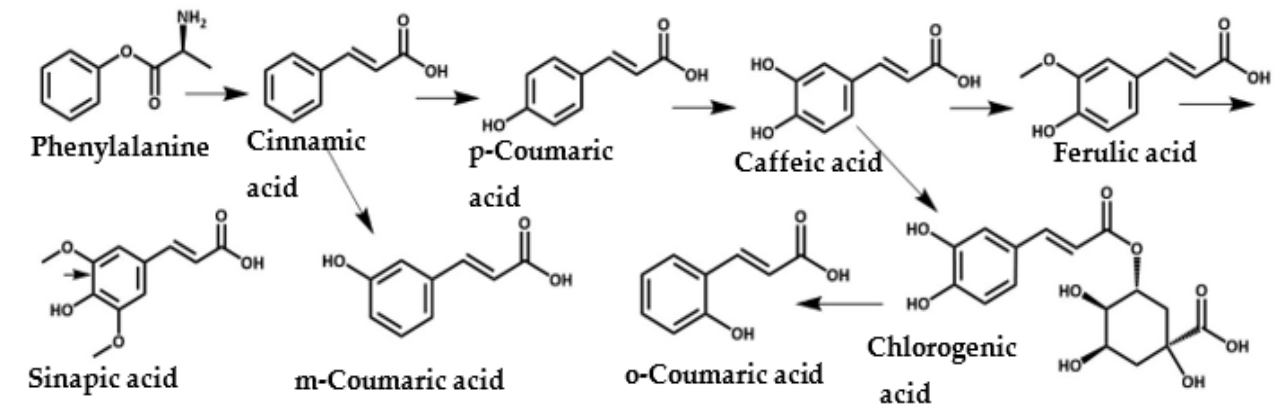
Figure 1. Natural biosynthesis map of cinnamic acid derivatives in plants [31,32].